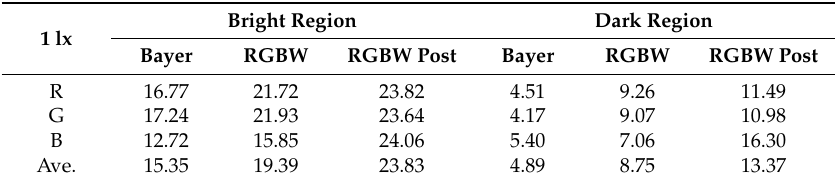
Table 2. Comparisons of signal-to-noise ratio (SNR) in bright and dark regions at 1 lx. Bright Region 1 lx